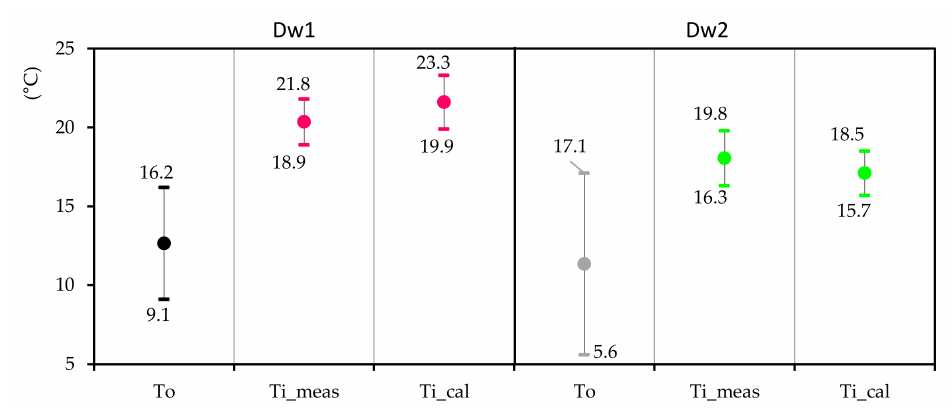
Figure 10. Average and daily variability of outdoor ( T o ) and indoor temperature measured ( T i _meas) and calculated ( T i _calc) of Dw1 (magenta) and Dw2 (green), at 20 Feb (clear sky